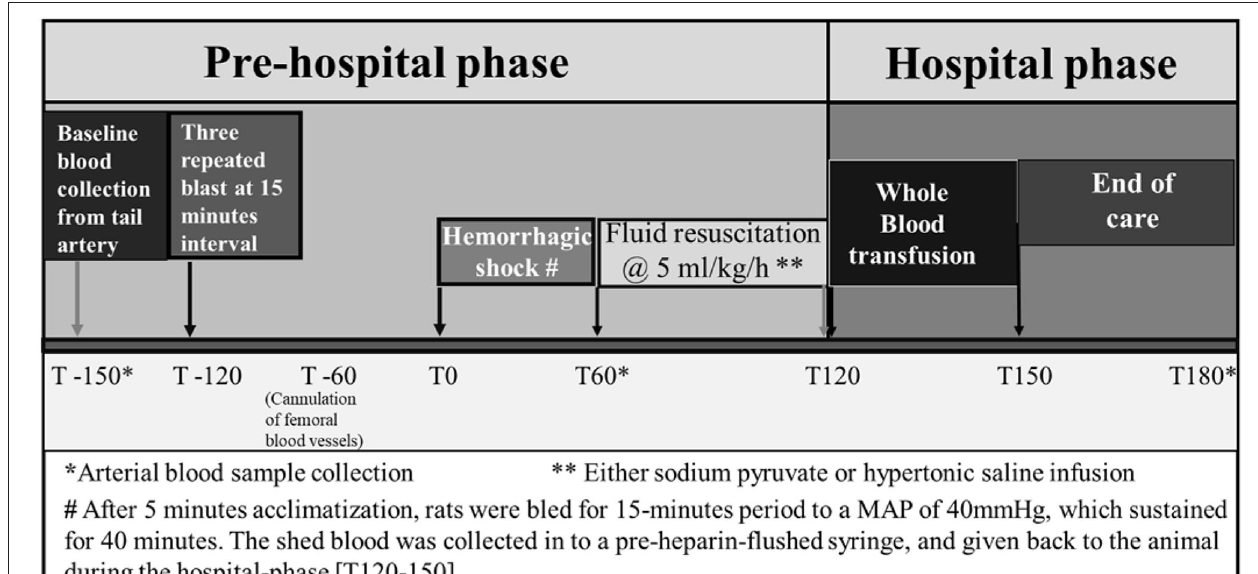
FIGURE 1 | Experimental design established to conduct the study protocol of hemorrhagic shock and/or blast